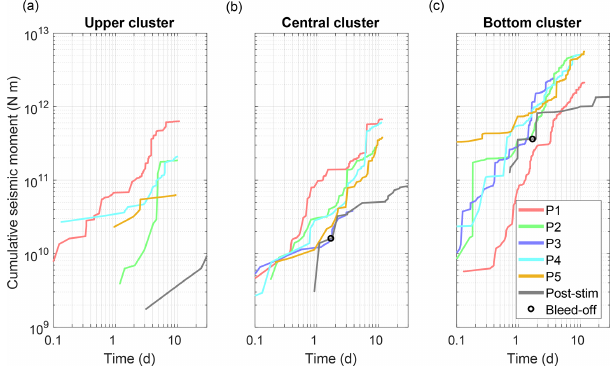
Figure 3. Hypocenters of relocated events. (a) Map view and (b) SW–NE depth section. The hypocenters are color-coded with the stimulation phases (see Kwiatek et al., 2019), and the size cor- responds to moment magnitude. Relocated seismicity that occurred after the stimulation is represented as grey dots. Areas with large events occurring during stimulation phase P 5 and post-stimulation time are highlighted by red rectangles (see main text for details). The five injection stages are marked as color bands along the bore- hole trace from the bottom of the open hole toward the casing shoe of the injection well OTN-3 (black). The new OTN-2 well (grey) was drilled in 2019 to 2020 after the stimulation.